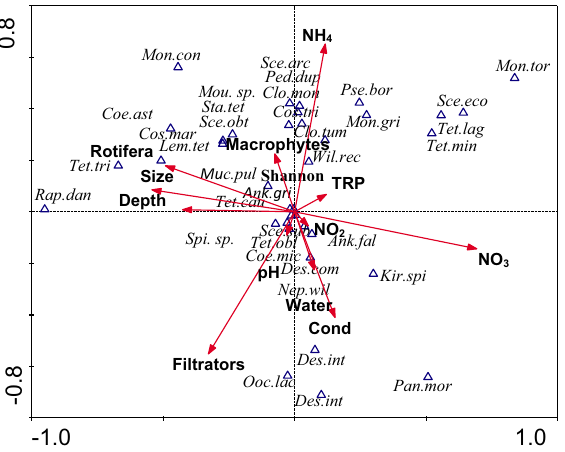
Figure 2. CCA diagram of the distribution of chlorophyte dominating species and diversity in relation to environmental factors in two types of pond habitats (Water—open water and Macrophytes—macrophyte- dominated zones). Abbreviation: Cos.mar— Cosmarium margaritatum ; other see Fig. 1.